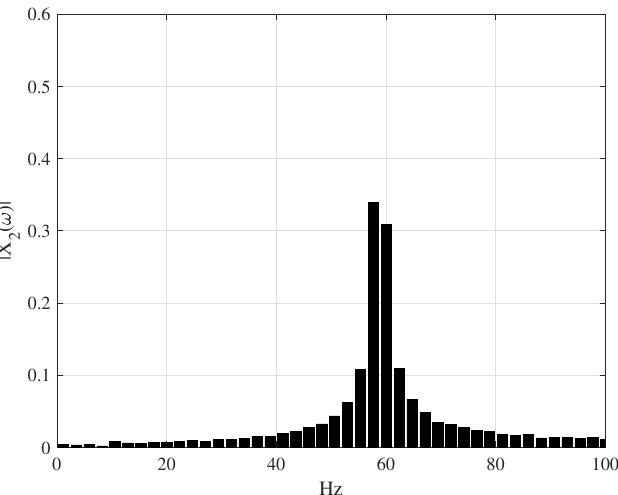
Figure 9. Output voltage harmonic content with α = 377 (60